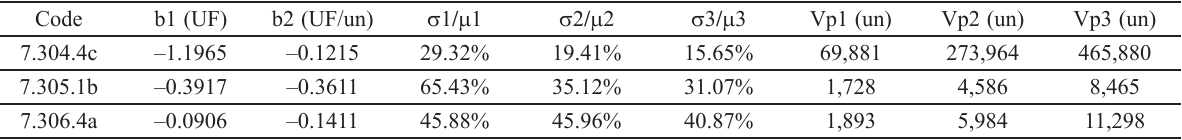
Table 2. Parameters obtained from MATLAB regression